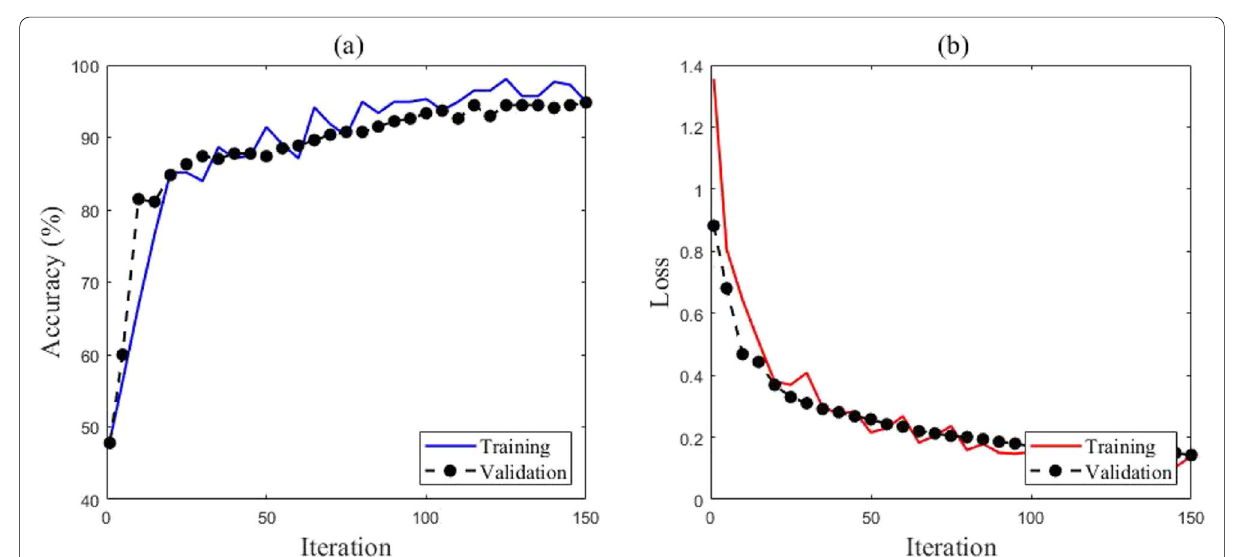
Fig. 15 Training stage: ( a ) performance and ( b ) loss of the proposed method using the experimental